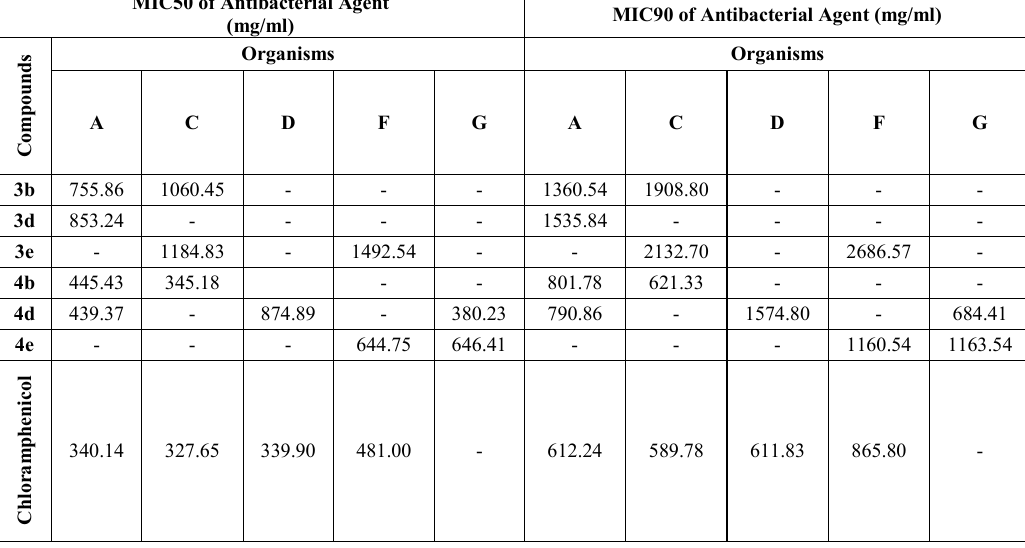
Table 4: Minimum inhibitory concentration (MIC) values (MIC50 & MIC90) of Most Potent compounds measured on standard bacterial strains. MIC50 of Antibacterial Agent